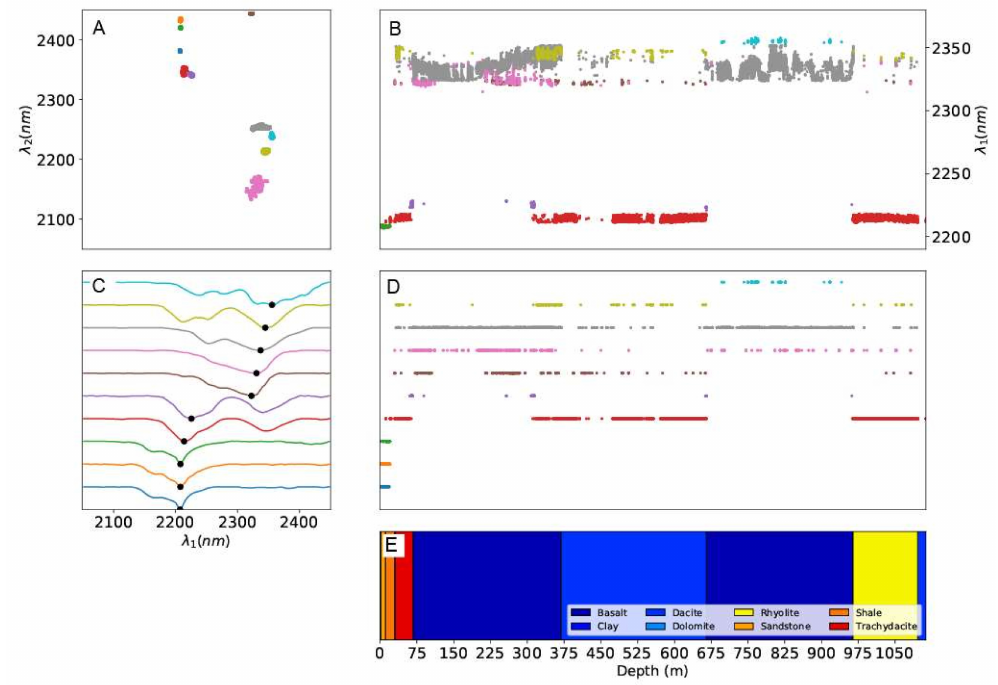
Figure 4. The 1st and 2nd deepest wavelength location of the extracted features in the 2050–2450 nm spectral region of the MSDP01 dataset ( A ), the down hole deepest feature as a function of hole depth ( B ). ( C ) shows the calculated MSR assemblages for each of the clusters in the top-left while the ( D ) plot shows the down hole distribution of those assemblages and ( E ) is the geologists logged litholgy. See the text included in the Results section for a more detailed explanation of the individual